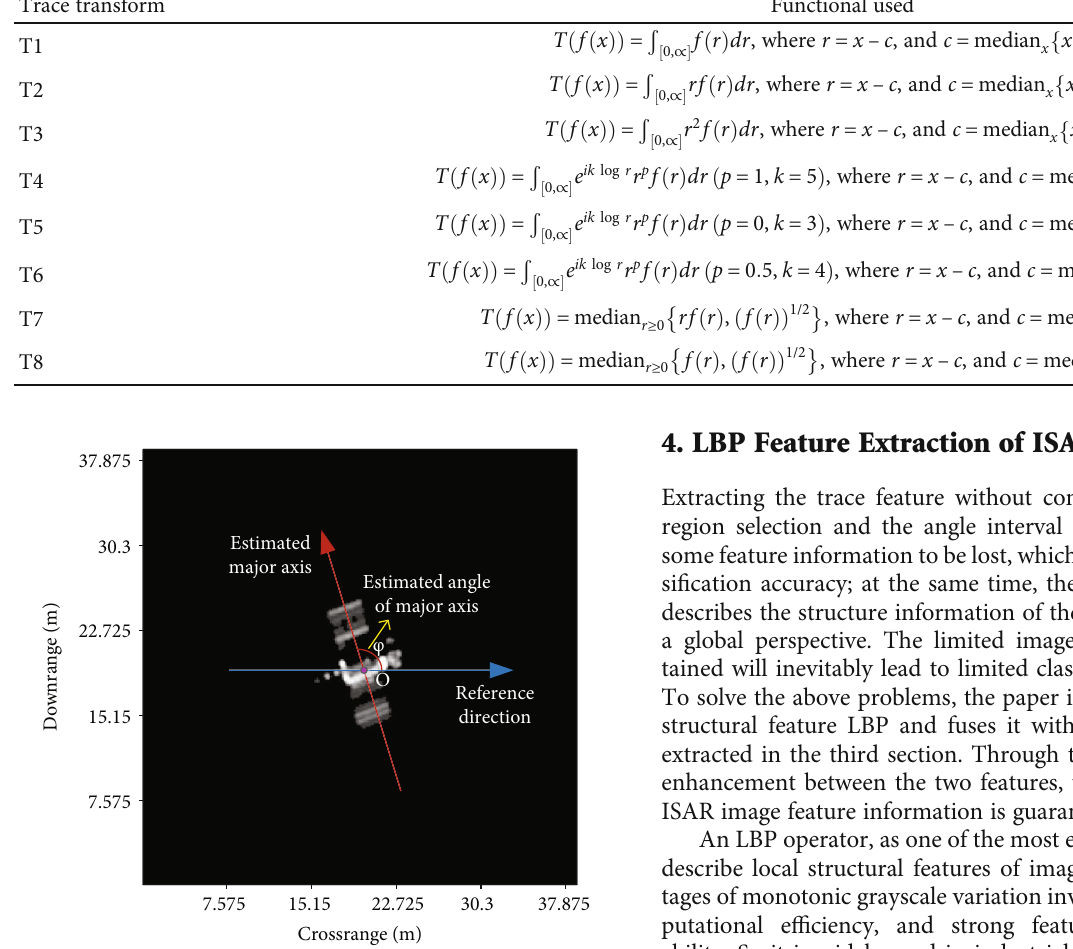
Table 1: 8 trace transform functions. Trace transform Functional used